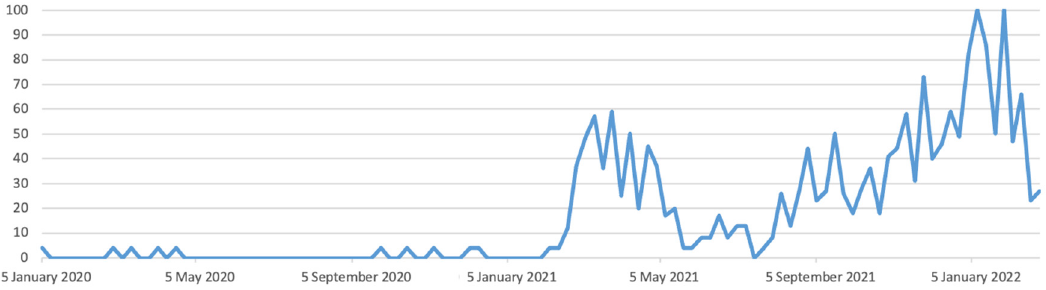
Figure 1. Worldwide searched term on Google for “NFT Audio”.